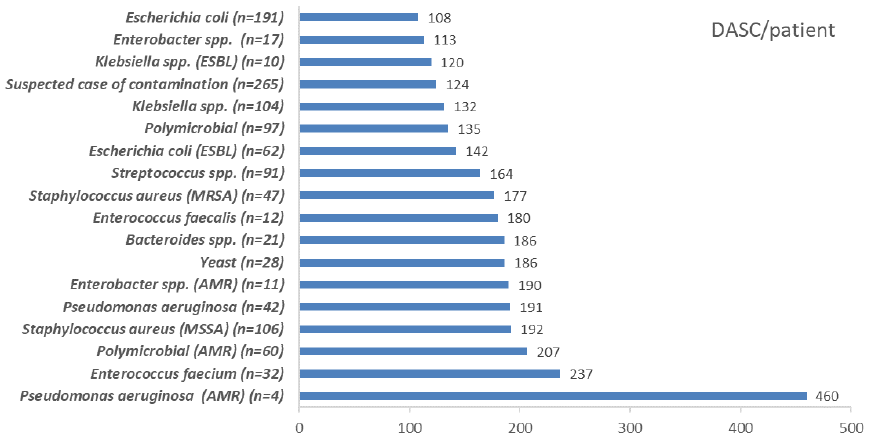
Figure 5. The DASC/patient distribution stratified by BSI pathogens. DASC, days of antibiotic spectrum coverage; BSI, bloodstream infection; MSSA, methicillin-susceptible Staphylococcus aureus ; MRSA, methicillin-resistant Staphylococcus aureus ; ESBL, extended-spectrum beta-lactamase; AMR, antimicrobial resistance.